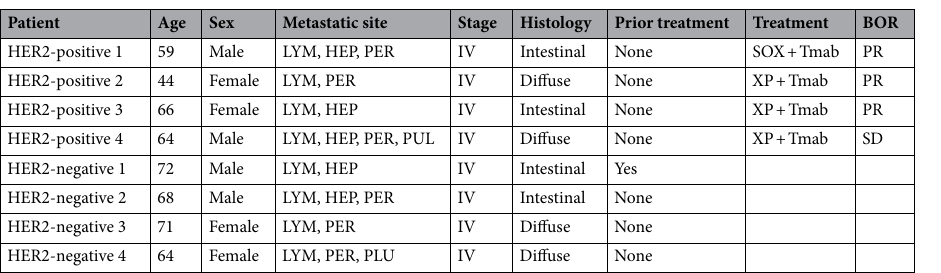
Table 1. Summary of clinical information on the patients for the phosphoproteomic analysis. Best overall response was defined according to the Response Evaluation Criteria in Solid Tumors (RECIST) version 1.1. BOR best overall response, HEP liver, HER2 human epidermal growth factor receptor 2, LYM lymph node, PER peritoneum, PLU pleura, PR partial response, PUL lung, SD stable disease, SOX S-1 plus oxaliplatin, Tmab trastuzumab, XP capecitabine plus